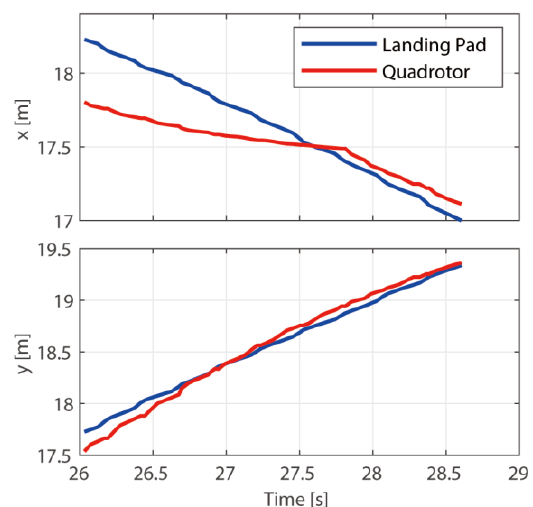
Figure 12. Position of quadrotor and landing pad near the landing point.